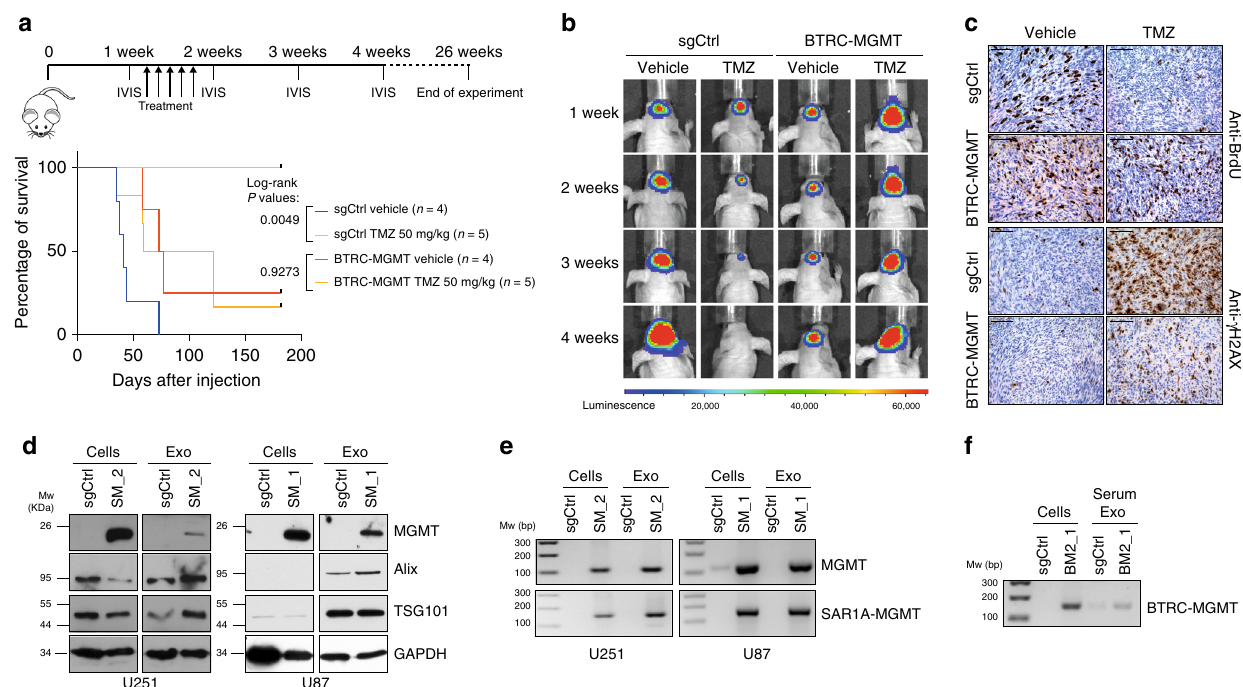
Fig. 4 MGMT fusions confer TMZ resistance in vivo and serve as biomarkers at recurrence. a Top panel: scheme of the in vivo experimental design . Bottom panel: Kaplan – Meier survival curve of animals intracranially injected with U251 sgCtrl and U251 BTRC-MGMT clone 2 cells transduced with a luciferase construct, treated or not with TMZ (50 mg/Kg) for 5 days: sgCtrl Vehicle n = 4, sgCtrl TMZ n = 5, BTRC-MGMT vehicle n = 4, BTRC-MGMT TMZ n = 5. sgCtrl log-rank P -value = 0.0049, BTRC-MGMT log-rank P -value = 0.9273. b Representative luminescent images of the tumor bearing at the indicated time points. c Immunohistochemistry analysis against BrdU and γ H2AX of tumors from mice injected with U251 sgCtrl and BTRC-MGMT clone 2 cells, treated or not with TMZ (50 mg/kg) for 3 days. Mice were sacri fi ced 2 h after BrdU injection. Scale bars: 100 μ m. d Western blot analysis of the EXO markers Alix and TSG101 and of MGMT levels in samples pair of cells and cell-derived EXOs expressing sgCtrl and SAR1A-MGMT. e SAR1A-MGMT and MGMT mRNA expression by RT-PCR in RNA pair samples from cells and cell-derived EXOs expressing sgCtrl and SAR1A-MGMT. f Transcript levels